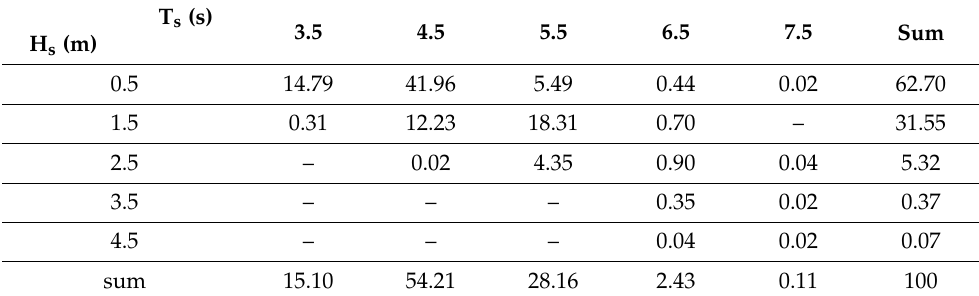
Table 4. Wave scatter diagram for Hsinchu offshore area